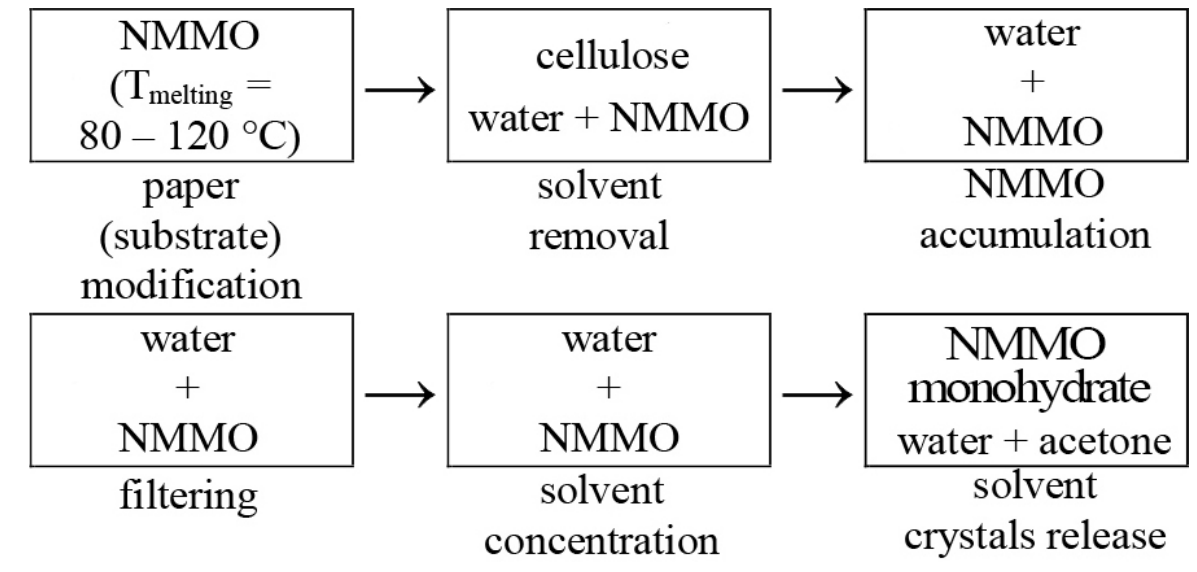
Figure 2. Block diagram of NMMO regeneration.